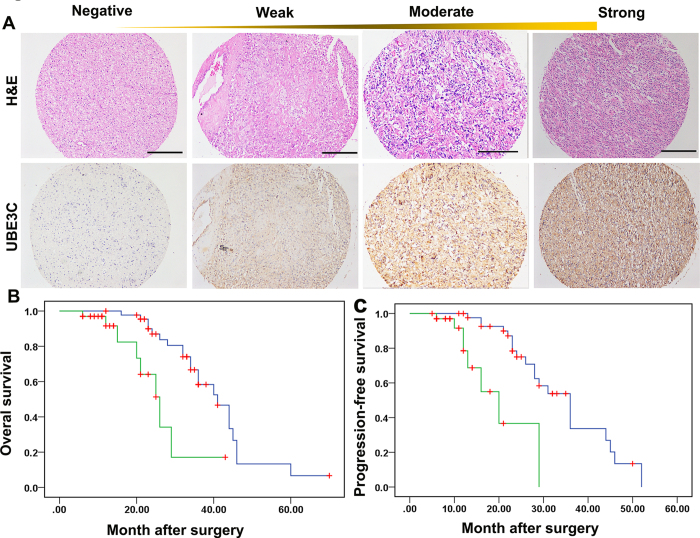
Overexpression of UBE3C was associated with the OS and PFS of gliomas Patients(A) Immunoreactivity of UBE3C protein was located in the cytoplasm of the gliomas cells (bar=50μm); (B) Prognostic significance assessed by Kaplan-Meier survival analysis, the OS and PFS of glioma patients compared by UBE3C. .